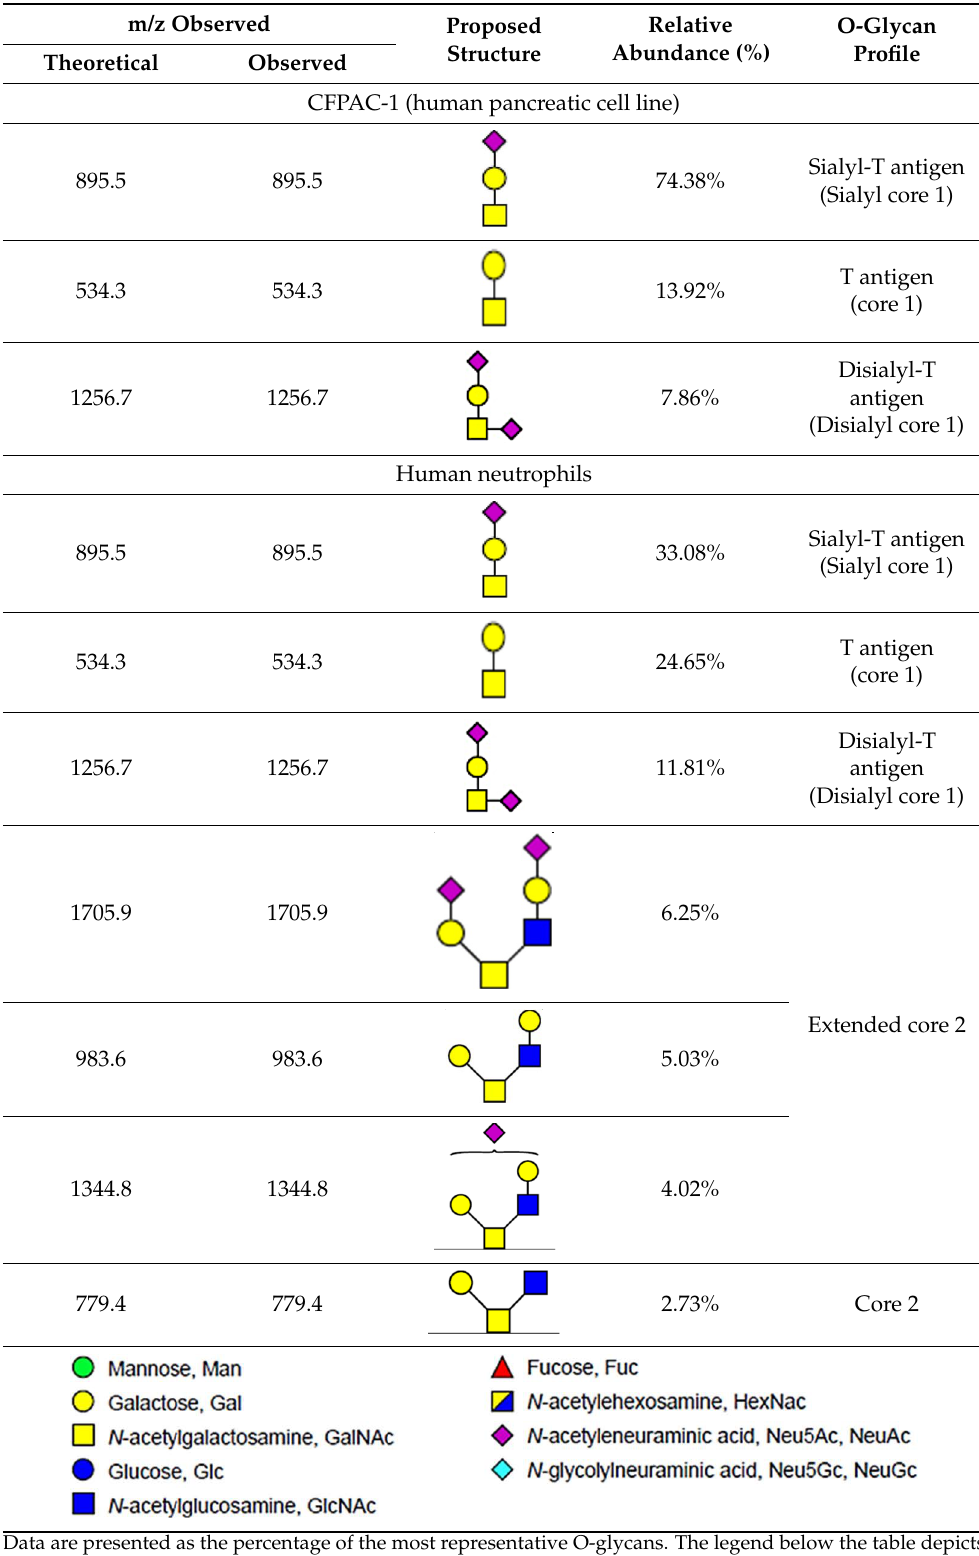
Table 1. O-glycan profile and relative abundance of CFPAC-1 and human neutrophils. m/z Observed